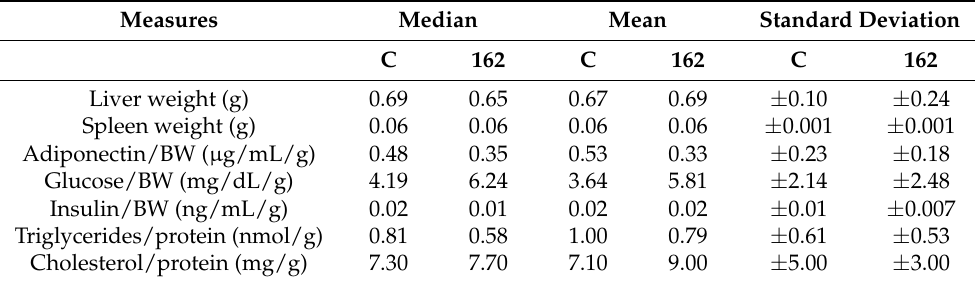
Table 1. Median, mean, and standard deviation of liver and spleen weight, serum adiponectin, glucose and insulin, and hepatic triglyceride and cholesterol levels (normalized to protein concentrations). None of these measures were changed by muChem-162 overexpression ( n = 7 mice per group; Mann–Whitney U test). BW, body weight. Measures Median Mean Standard Deviation